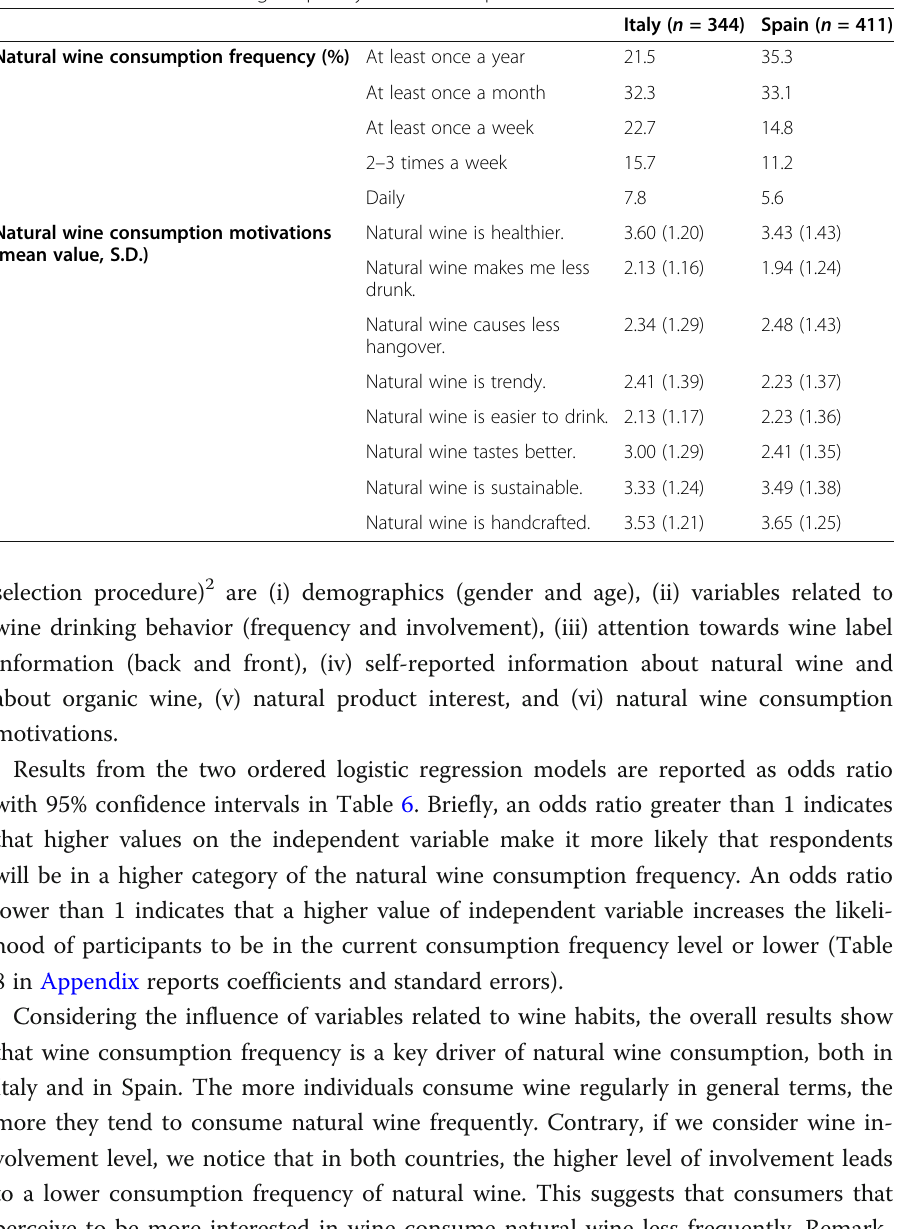
Italy ( n = 344) Spain ( n = 411)